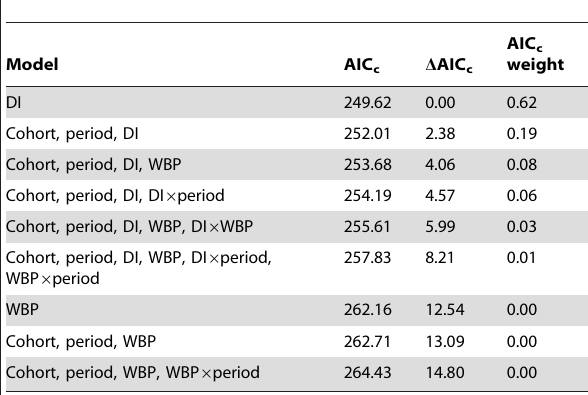
Table 2. Akaike’s Information criteria (AIC c ) of linear mixed- effects models 1 to examine relationships of covariates 2 with home-range size (km 2 ; 95% a -local convex hull) of female grizzly bears in the Greater Yellowstone Ecosystem.